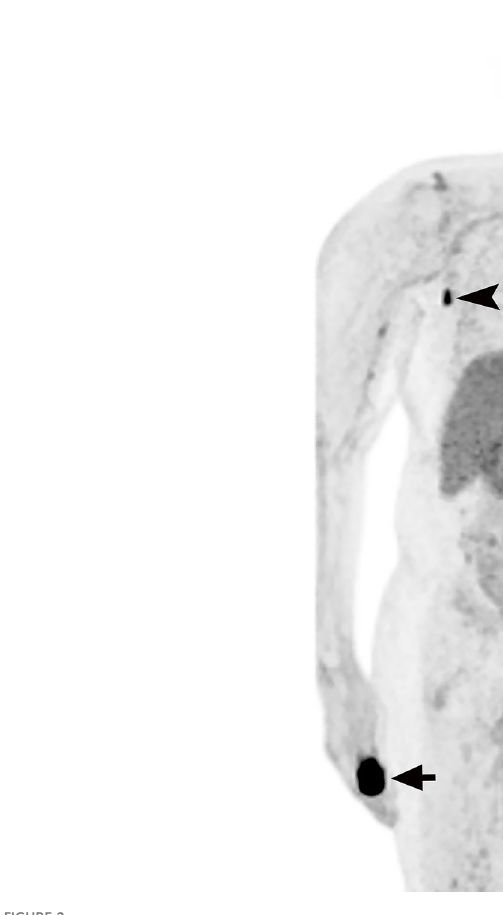
FIGURE 2 18 F-FDG PET reveals intense areas of 18 F-FDG uptake in the right thumb(arrow) and axillary lymph nodes